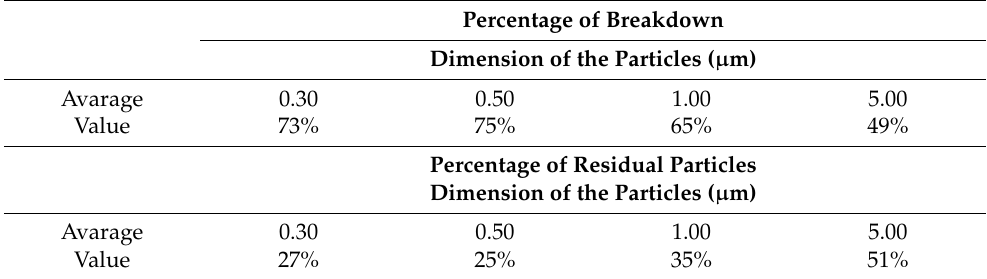
Table 1. Analysis of particles during activity H with PAC off and on.